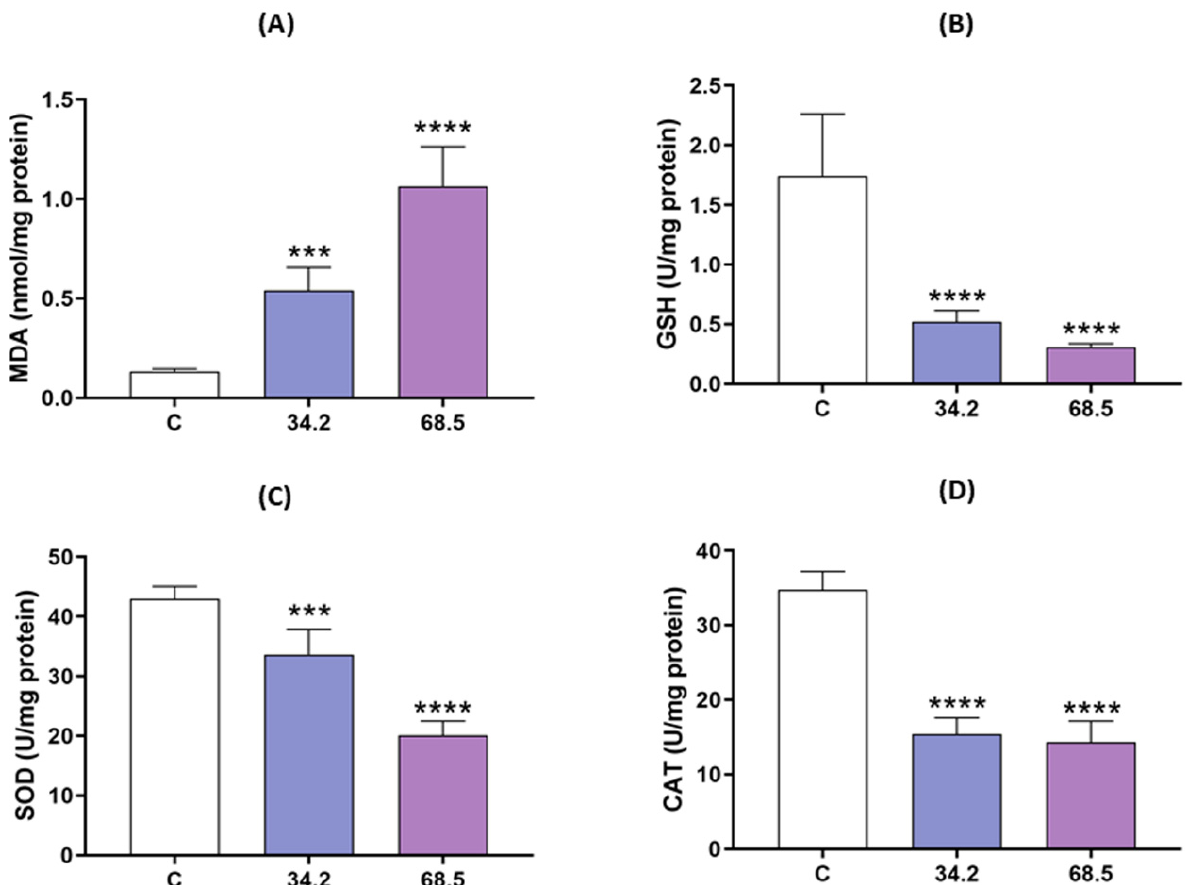
Figure 2. Allethrin treatment-induced oxidative stress. Pregnant female rats were exposed to 34.2 and 68.5 mg of allethrin/kg body weight from Day 6 of gestation until delivery, and the levels of MDA ( A ), GSH ( B ), SOD ( C ) and CAT ( D ) in female offspring were then determined during the prepubertal stage. All data are expressed as the means ± SDs. *** p < 0.0005; **** p < 0.00001.